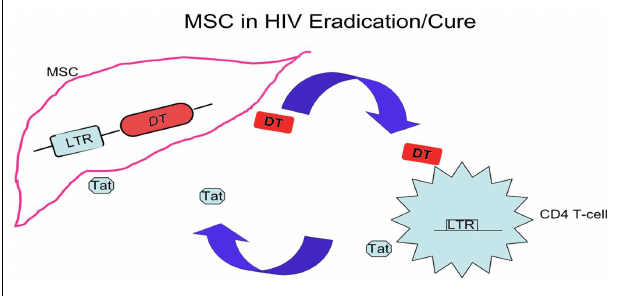
FIGURE 2 |A stem cell based treatment . In addition to hematopoietic stem cell transplant, other stem cells, such as MSC, can be used in HIV/AIDS eradication and cure via relatively easy cellular source and process.The modified MSC aim at compartments refractory to HAART, and this strategy is derived from the cell-based therapy killing cancer cells by pro-drug delivery with MSC. After transduction of LTR-DT gene and interaction with cells infected by HIV expressingTat, these MSC are activated and diphtheria toxins (DT) are generated.The toxin kills the infected CD4T-cells and nearby cells included MSC producing the toxin, by which eliminates the HIV-infected cells and the HIV